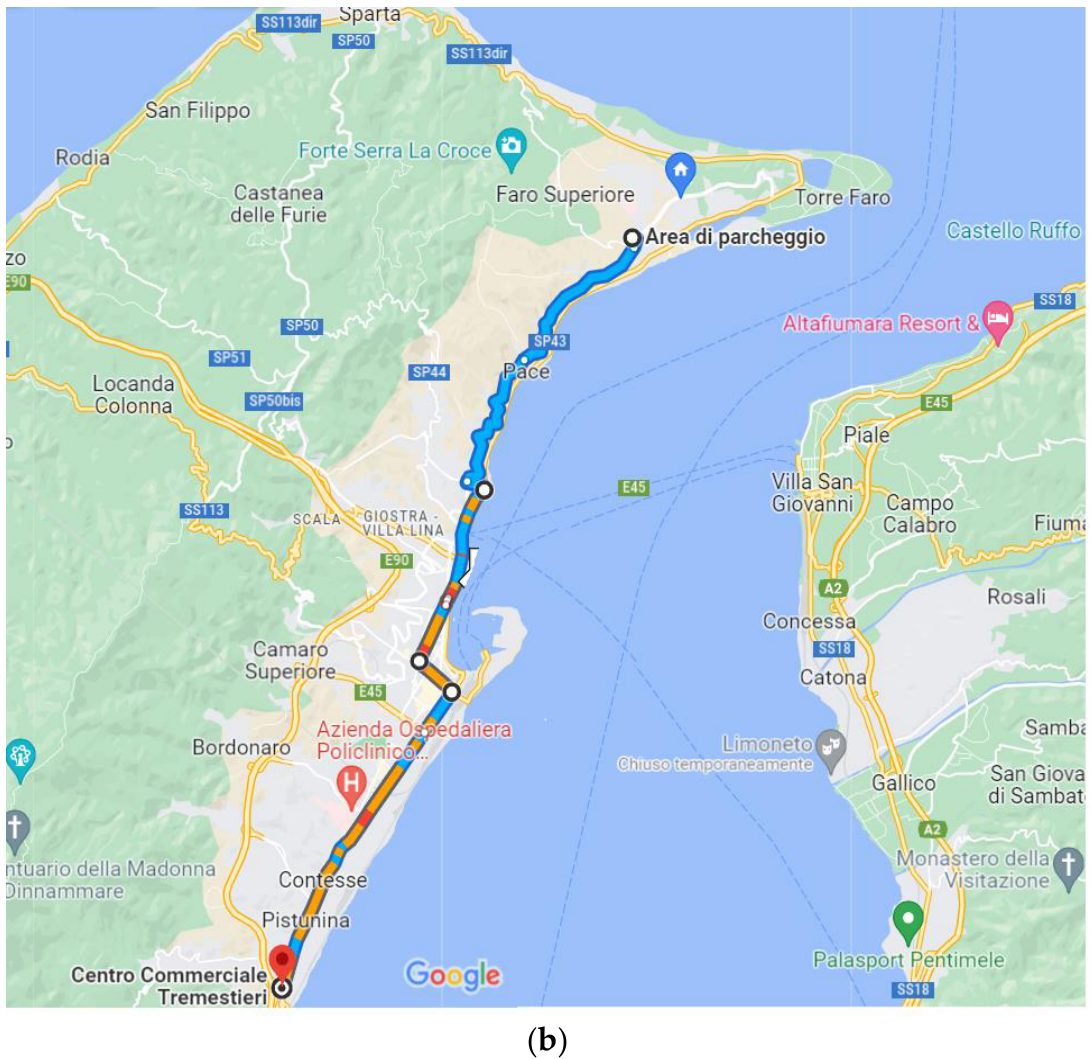
Figure 5. Data acquisition from GPS sensor. ( a ) Speed profile and altitude (0 value is the sea level); ( b ) Vehicle position.